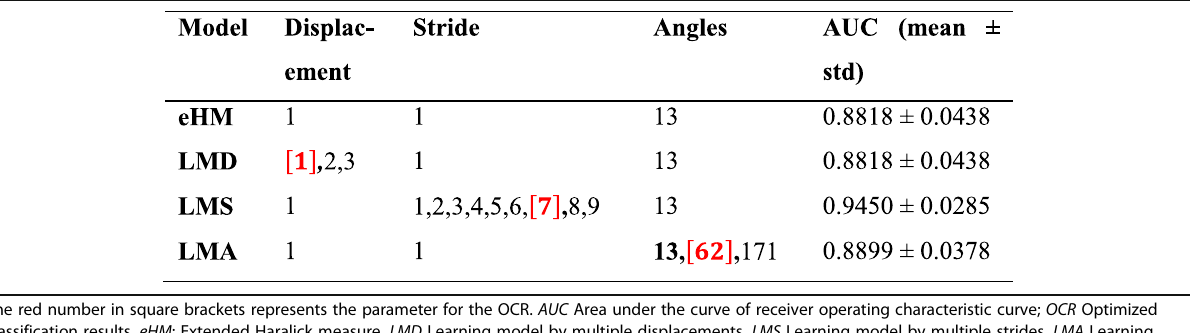
Table 4 The OCR for LMD, LMS and LMA